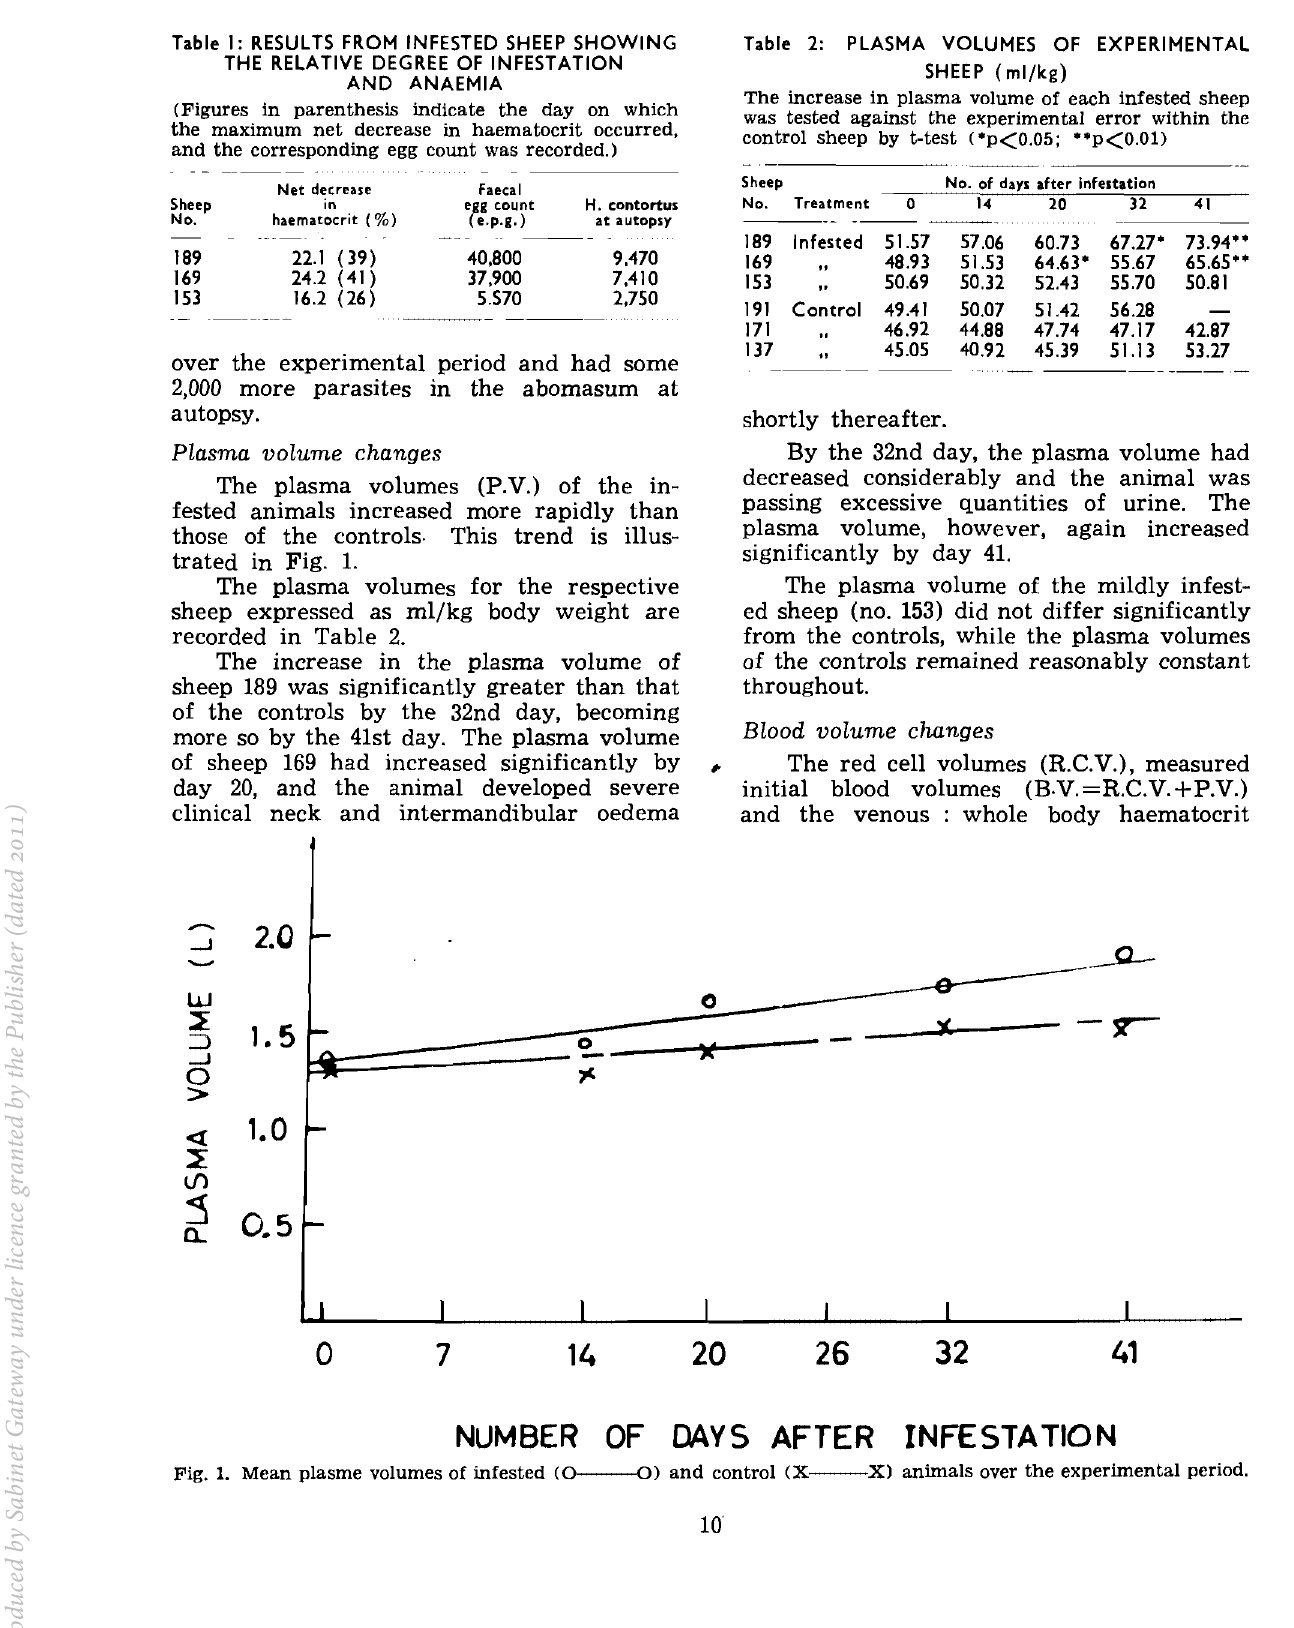
Table I : RESULTS FROM INFESTED SHEEP SHOWING THE RELATIVE DEGREE OF INFESTATION AND ANAEMIA